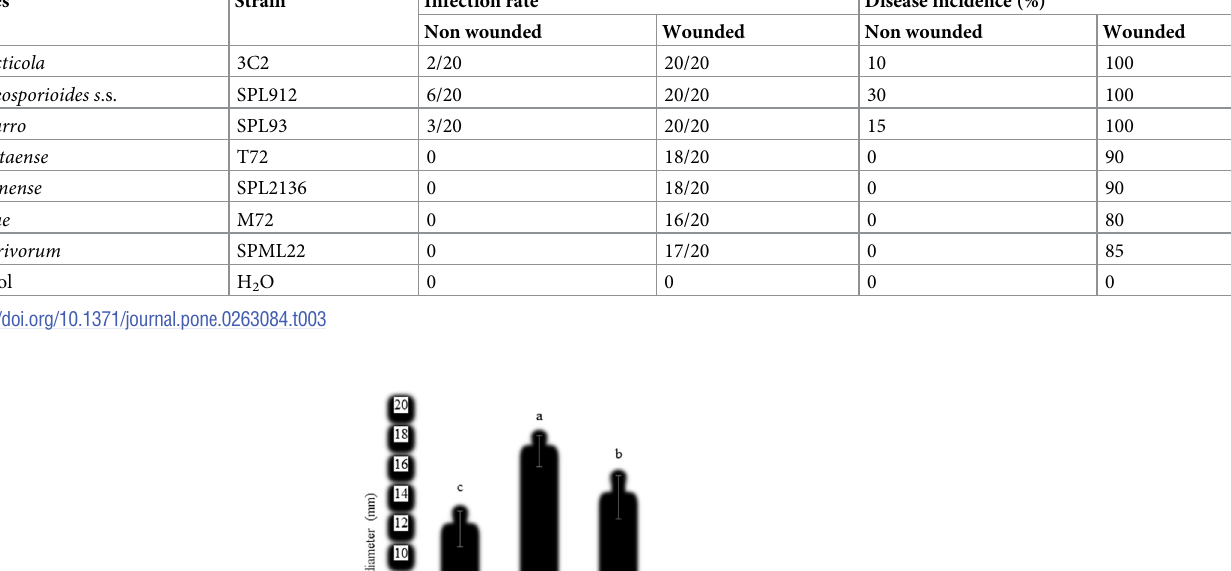
Table 3. Infection rates and disease incidence of Colletotrichum spp. inoculated on leaves of Atractylodes ovata . Species